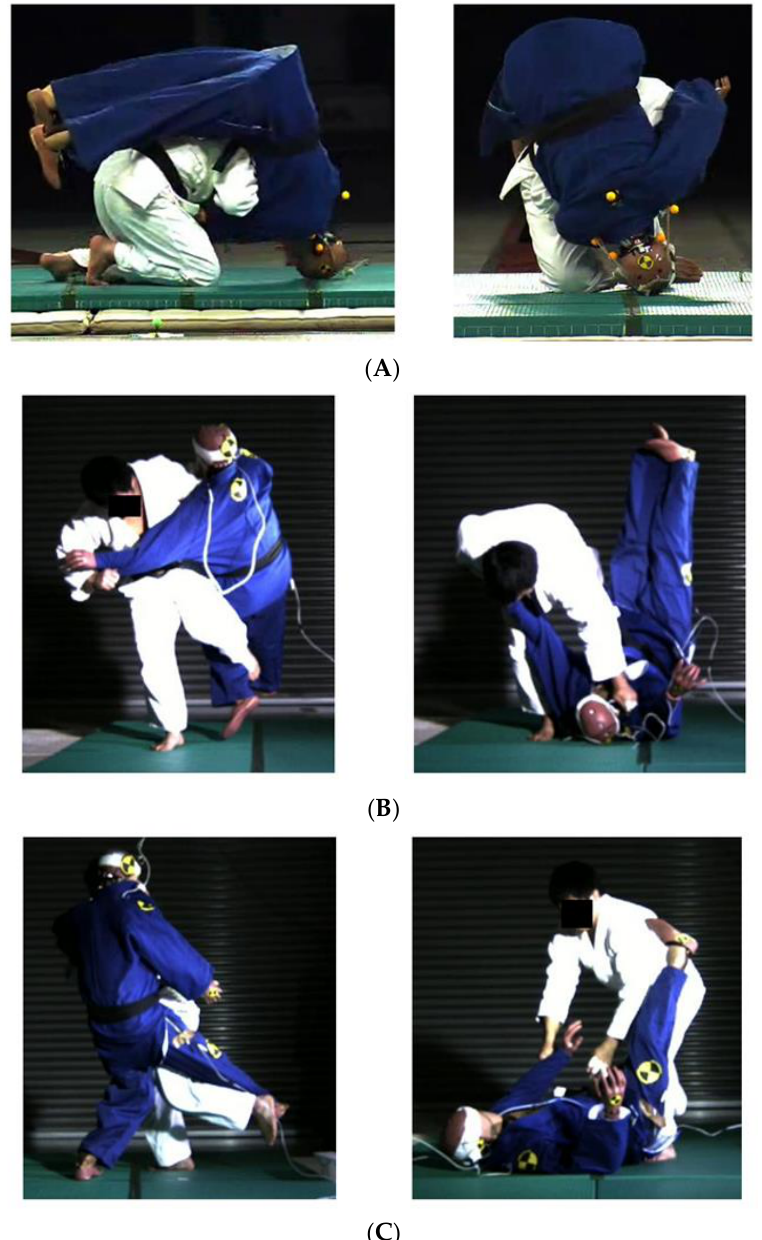
Figure 1. Representative kinematics of the dummy thrown by ( A ) Seoi-nage , ( B ) Osoto-gari , and ( C ) Ouchi-gari .